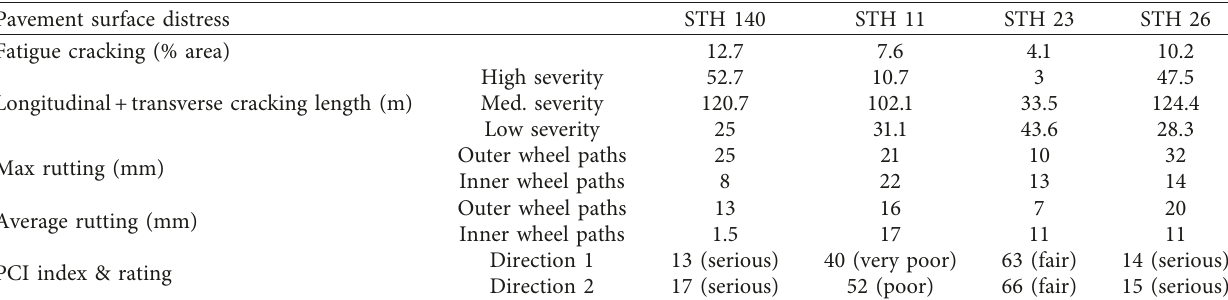
Table 3: Summary of pavement distress survey